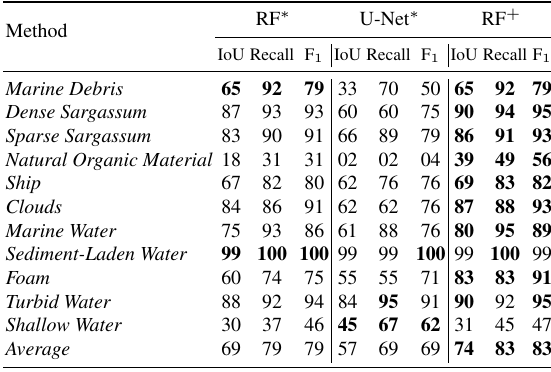
Table 1. Quantitative evaluation of the proposed RF + , compared